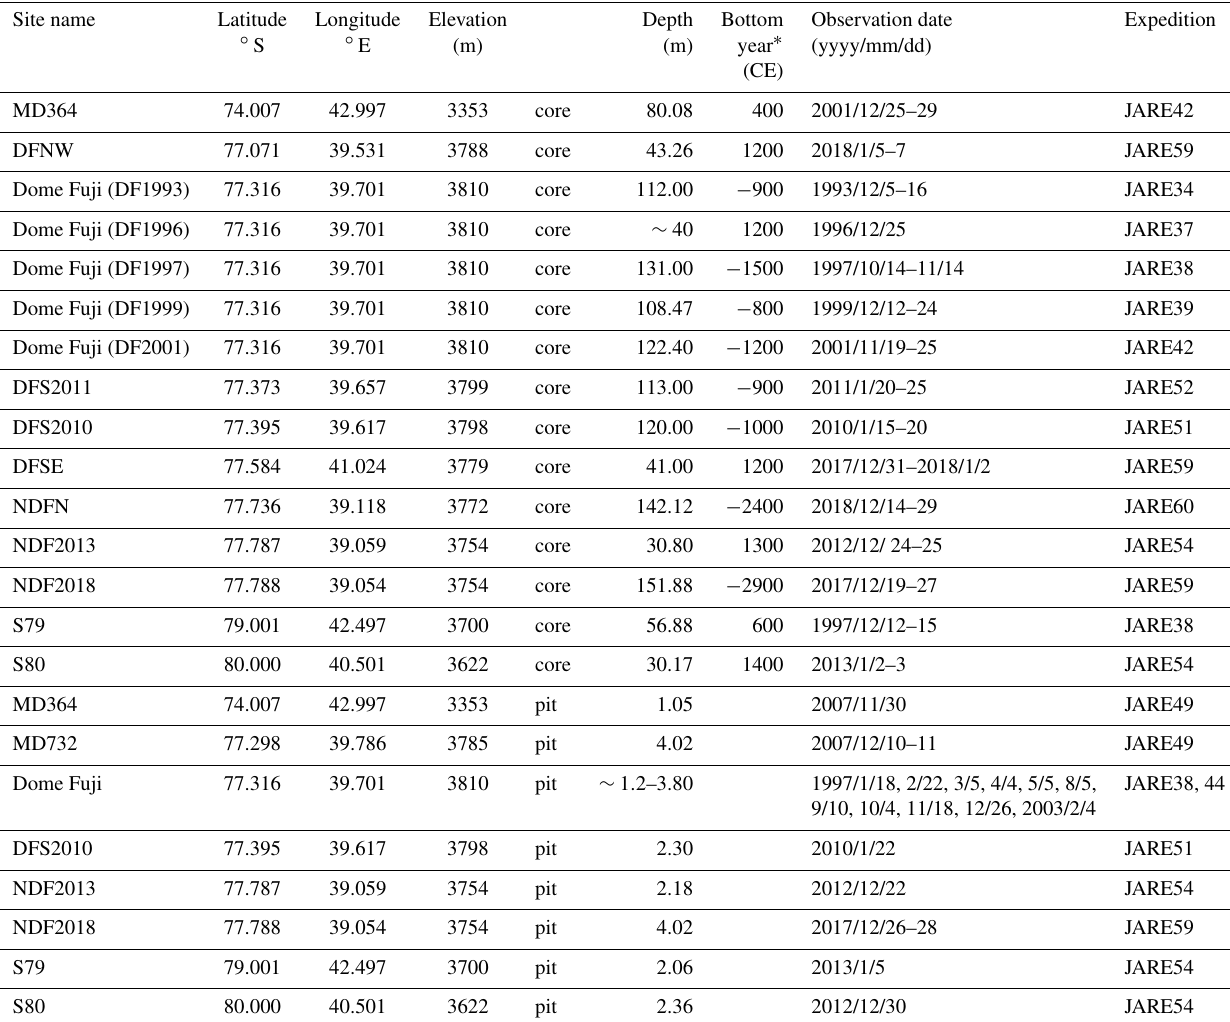
Table 1. Location, elevation, depth and observation date of the shallow cores and snow